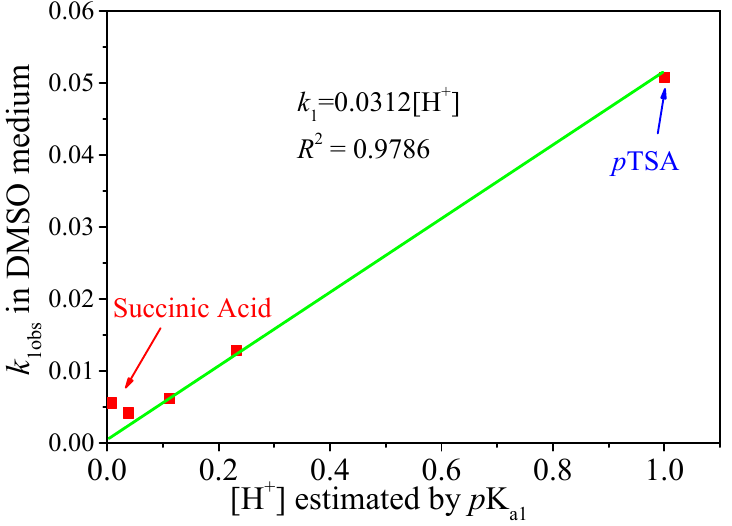
Figure 5. The dependency of experiment-determined k 1obs on [H + ] of the used organic acid catalysts in DMSO solvent medium.